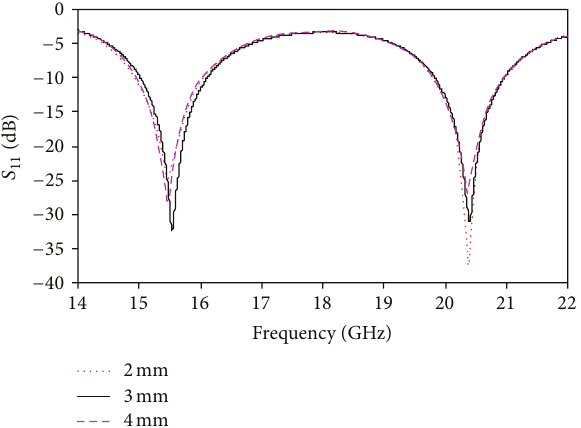
Figure 6: Simulated return loss for different values of 𝑊 2 .